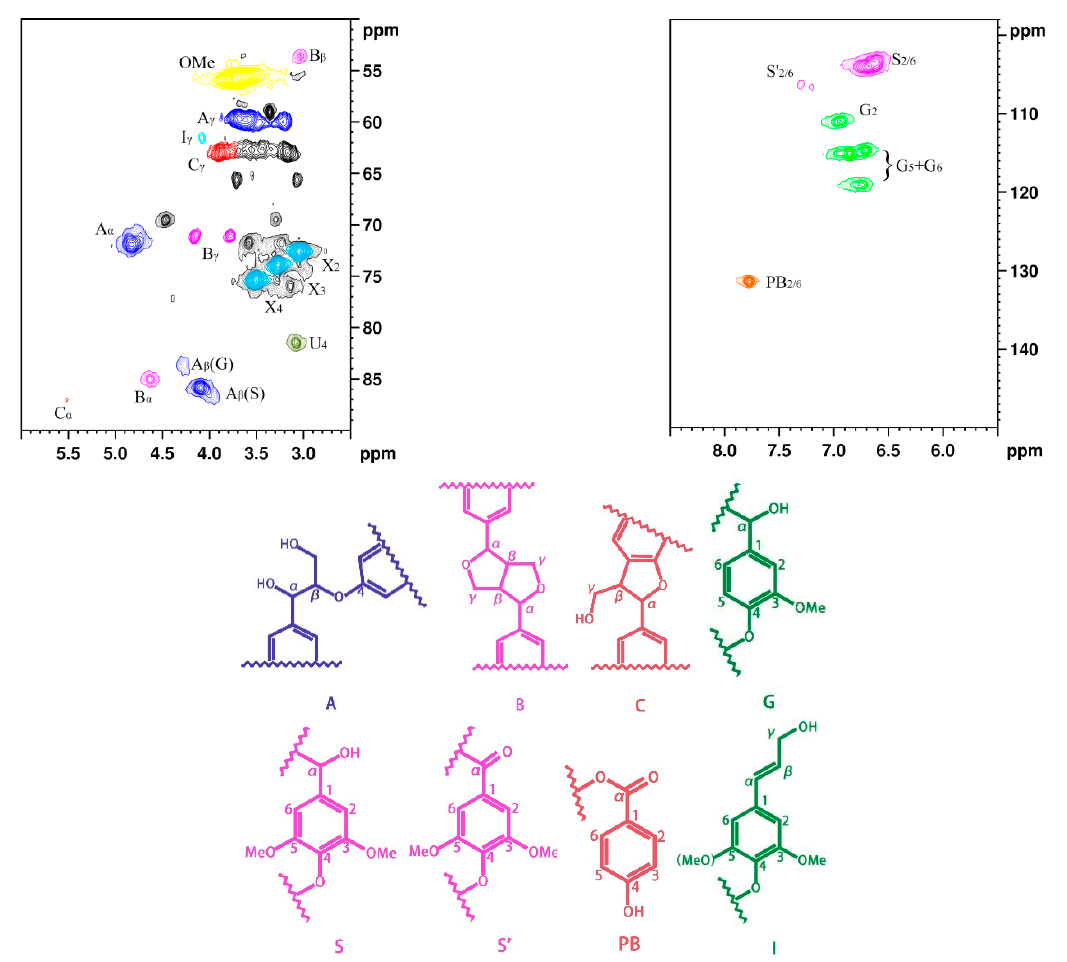
Figure 1. NMR spectrum of poplar lignin and the main chemical structures and linking modes.